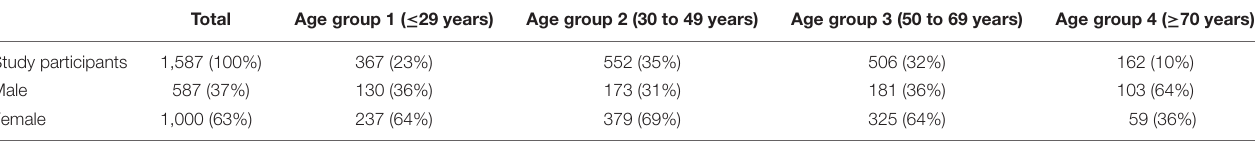
TABLE 1 | Study population and distribution across different age groups.